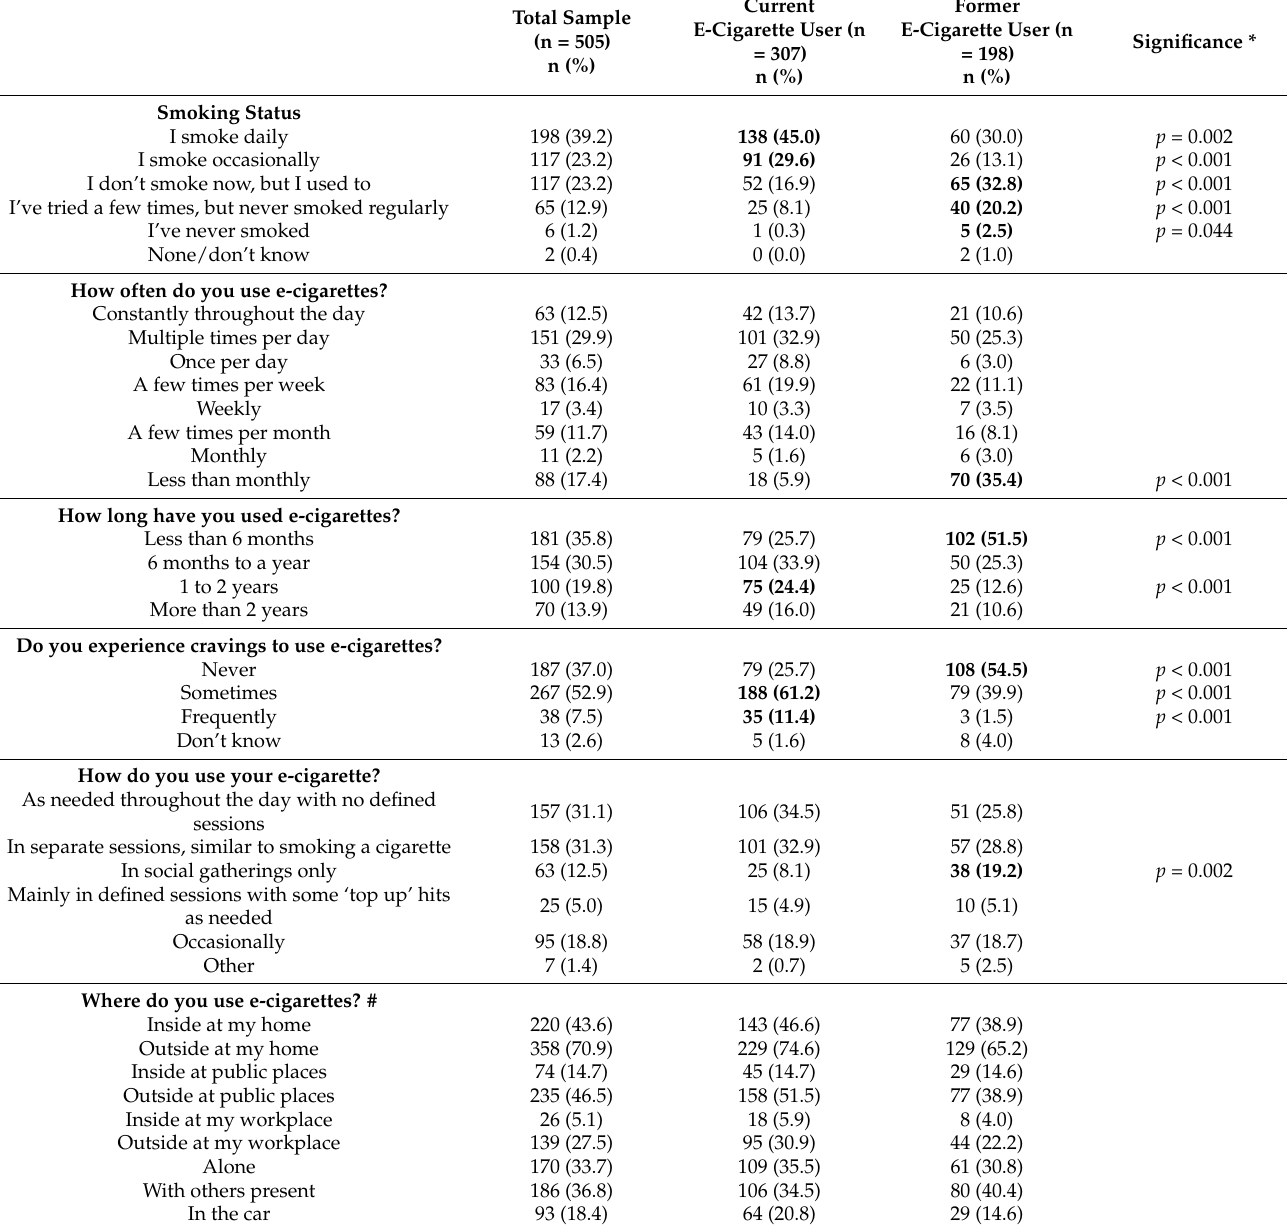
Table 2. Smoking history and e-cigarette usage. Numbers in bold indicate significantly greater than expected compared with current or former e-cigarette user for the same